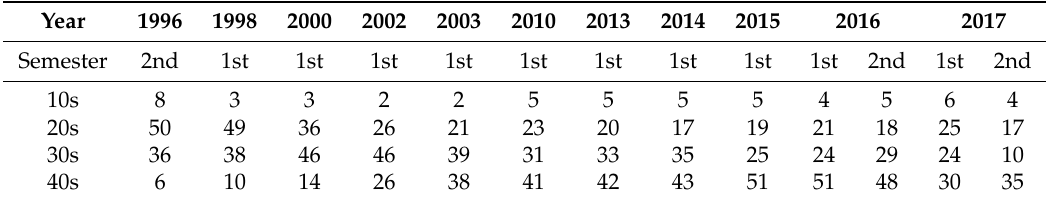
Table 2. Age Distribution of Postulants in the